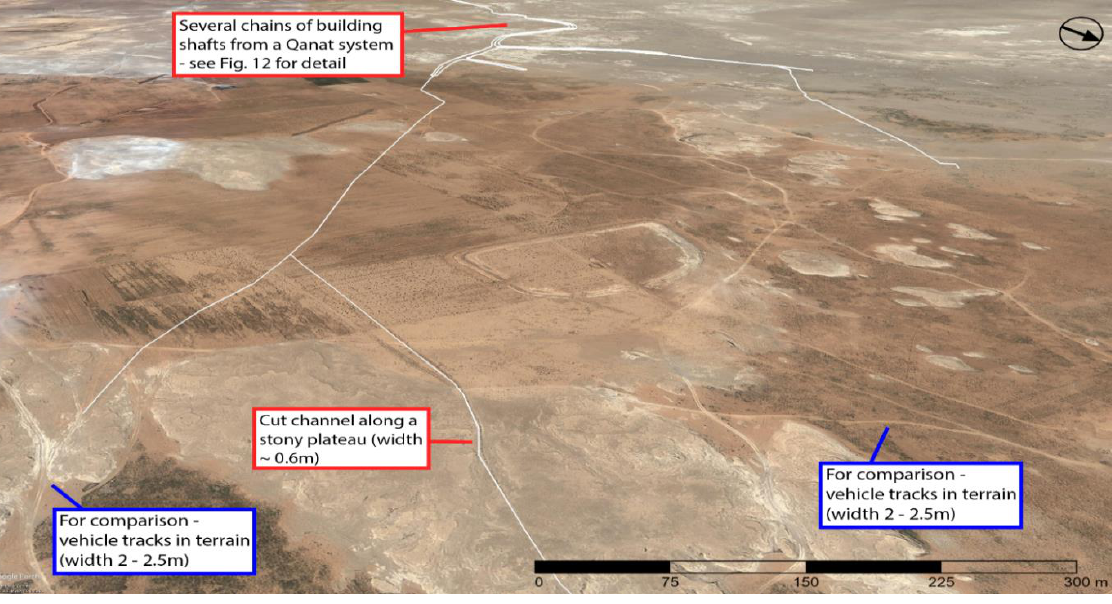
120 Lightfoot 1996,